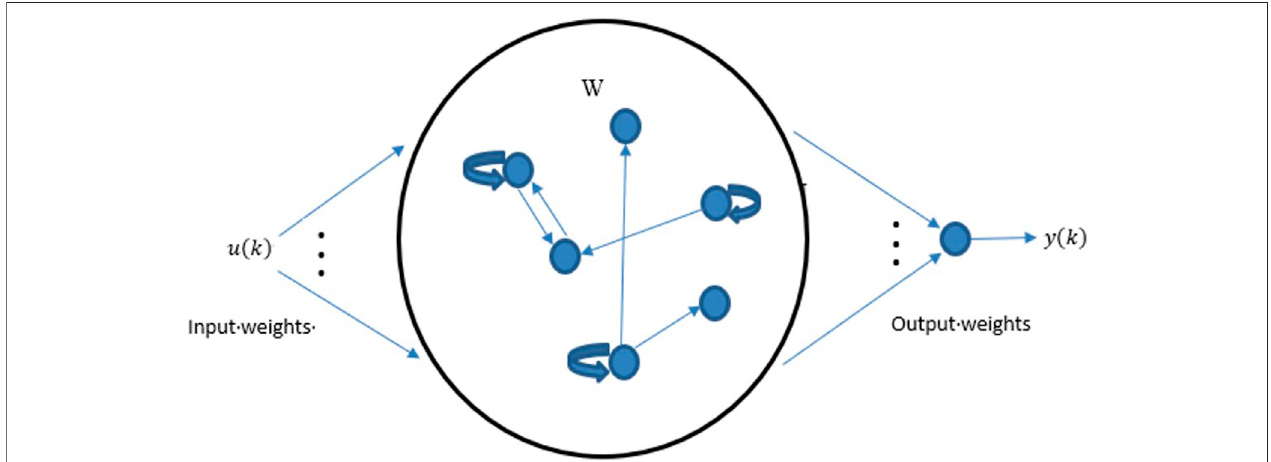
FIGURE 6 | Echo state network (ESN)